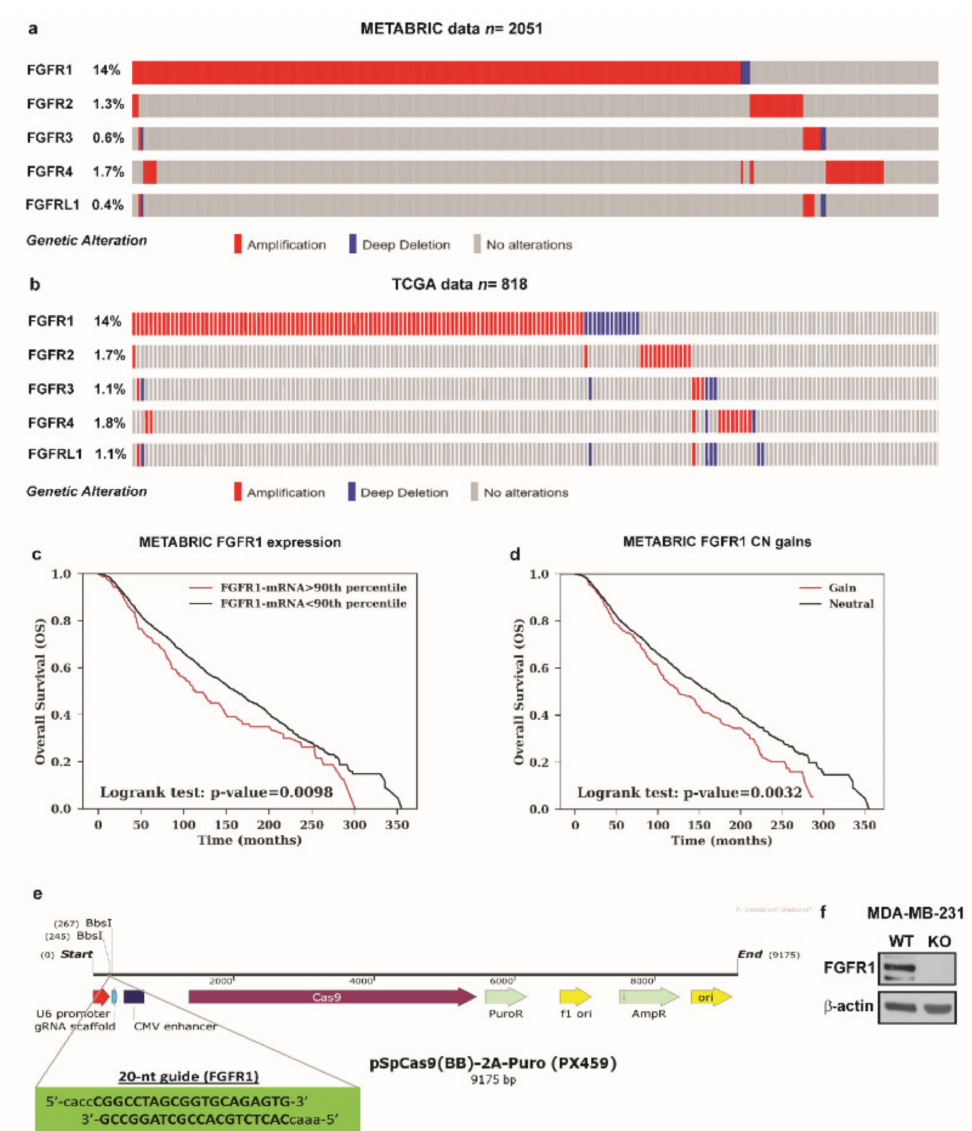
Figure 4. Analysis of METABRIC and TCGA datasets and CRISPR/Cas9-mediated FGFR1 knockout (KO) in MDA-MB-231 cells. ( a , b ) The OncoPrint of genomic alteration of FGFRs members showed that FGFR1 is the most amplified receptor of the family in human breast cancer patients. Each row represents a gene and each column represents a tumor sample. Red bars indicate gene amplifications, blue bars deep deletions and grey bars no alterations. ( c , d ) Kaplan-Meir plots show the overall survival (OS) from METABRIC dataset between patients with normal or high FGFR1 mRNA expression or between patients with copy number (CN) gains or without (neutral). Statistical analysis was performed using the long-rank test. ( e ) Schematic representation of the pX459 plasmid and the sgRNA sequence used to generate FGFR1 (KO) MDA-MB-231 cells. ( f ) Immunoblots of lysates generated from FGFR1 (WT) and FGFR1 (KO) MDA-MB-231 cells. β -actin served as loading control. Immunoblots shown are representative of three independent